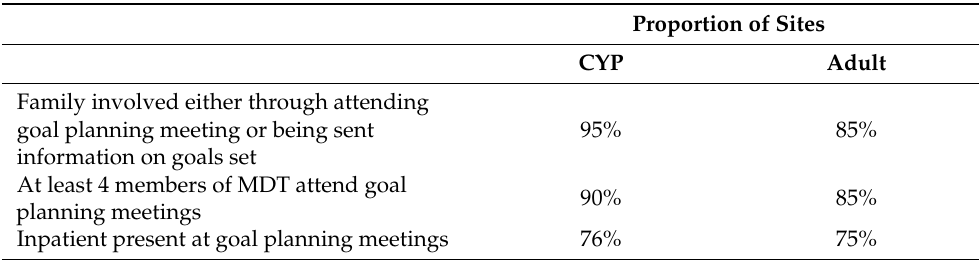
Table 8. Inpatient, family and MDT participation in goal planning across sites for CYP and adult inpatients in